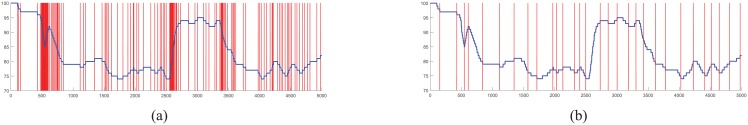
An example of salient points extracted from a given sequence.The blue curve represents the sequence of original health data. The point at which each red line parallel to the y-axis intersects the blue curve corresponds to a salient point.